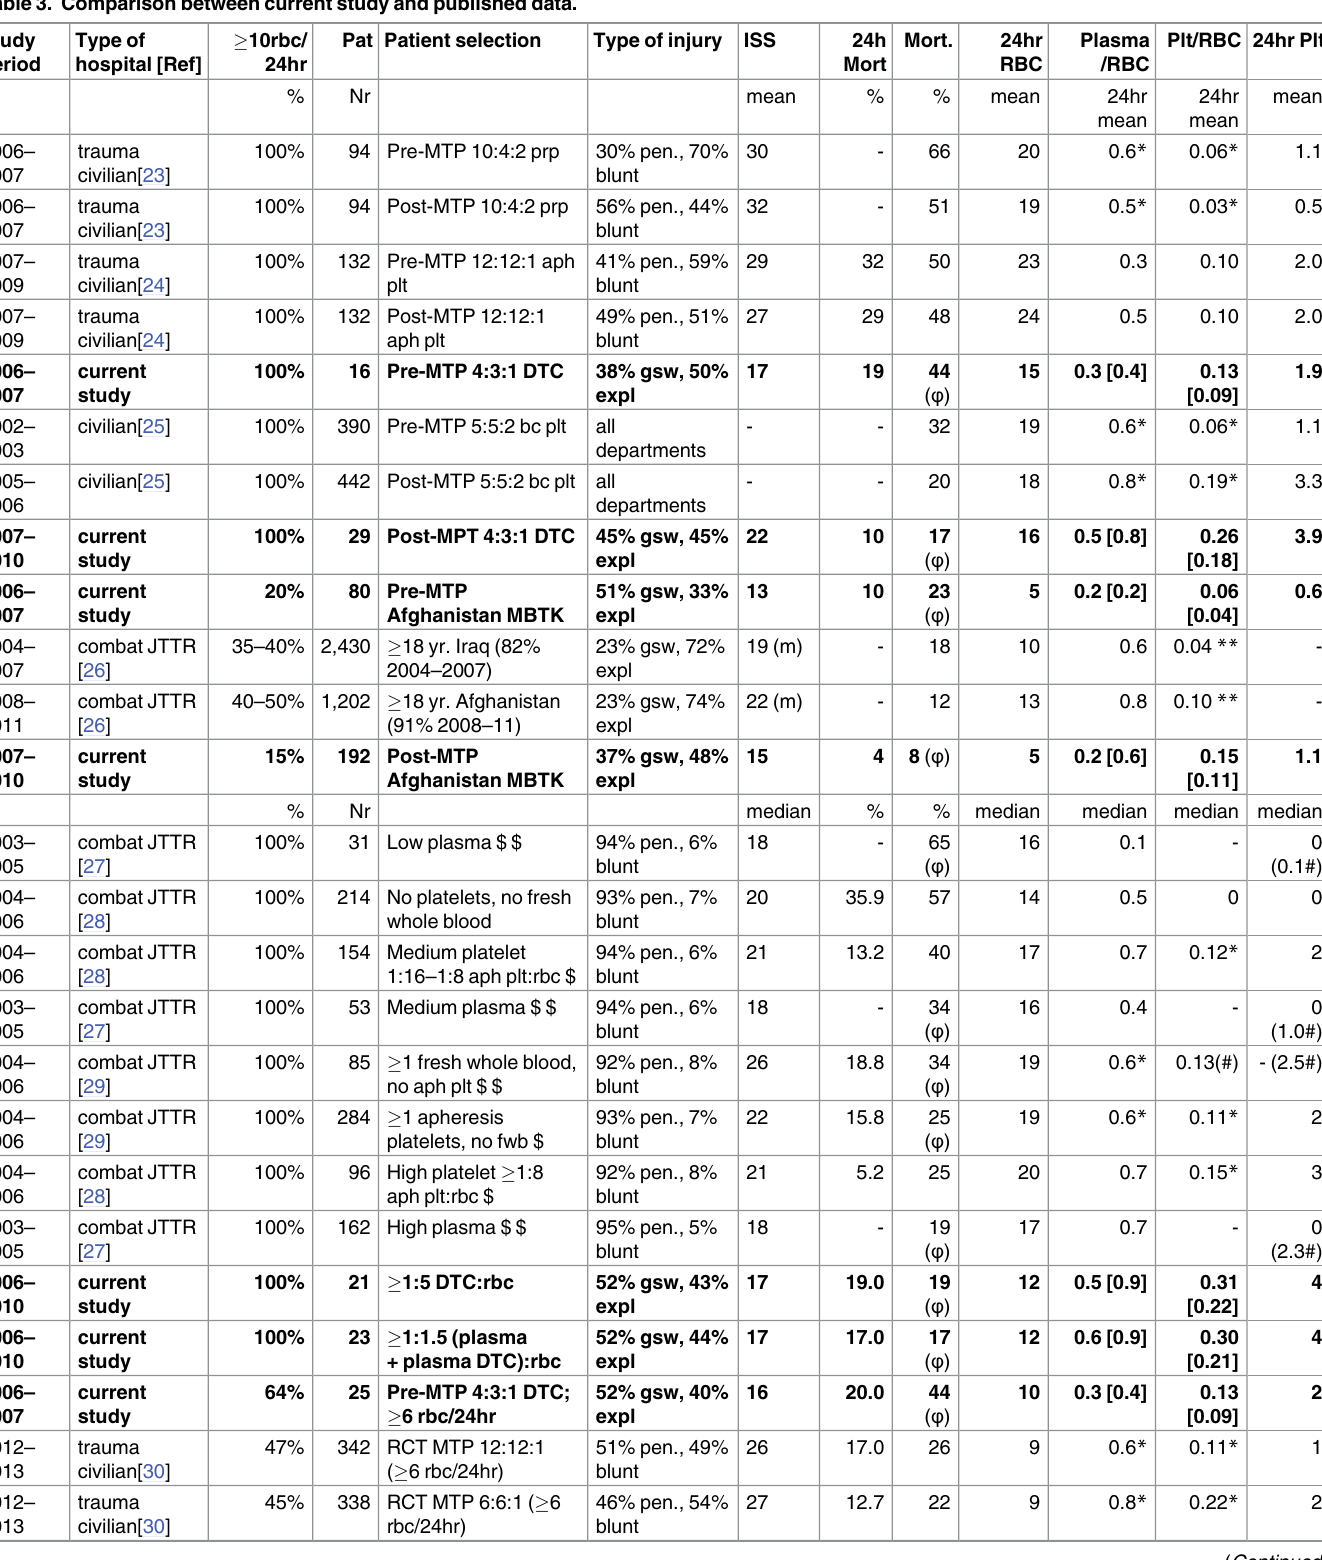
Table 3. Comparison between current study and published